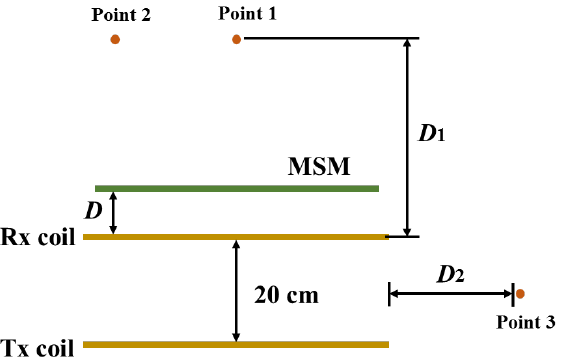
Figure 8. A simplified view of the measurement model.